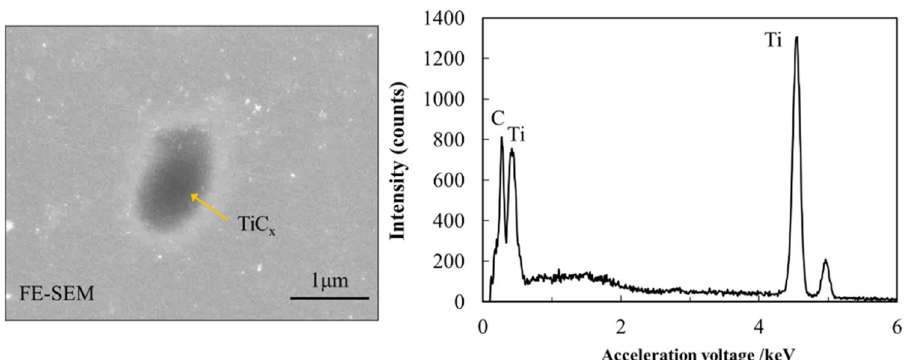
Figure 5. FE-SEM image and point analysis by EDS of TiC reinforced TMC sintered at 1273